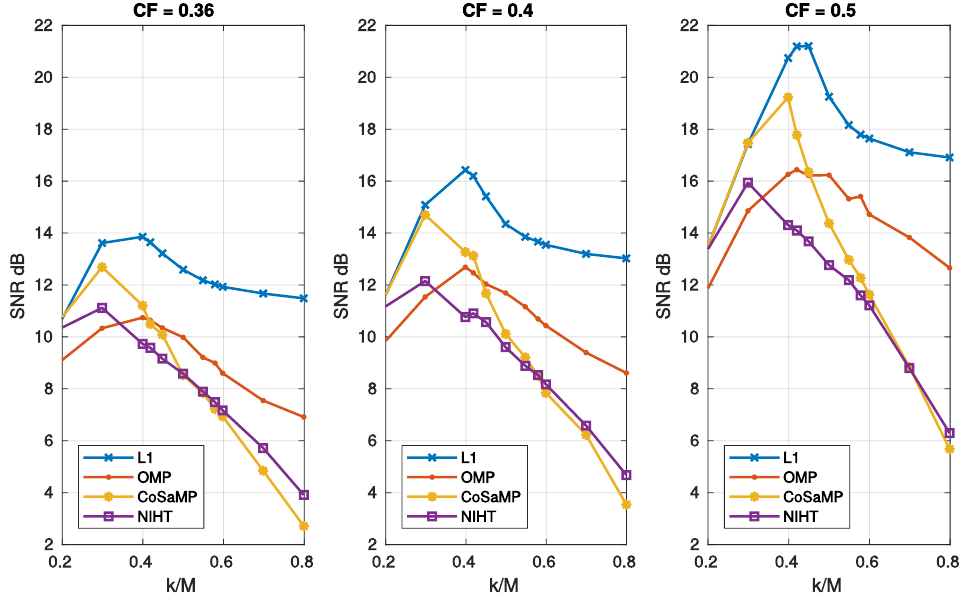
Figure 11. Case Study B—SNR as a function of sparsity S M = k / M and compression factor CF , for the four algorithms, L1, OMP, CoSaMP, NIHT, using the DB4 basis.